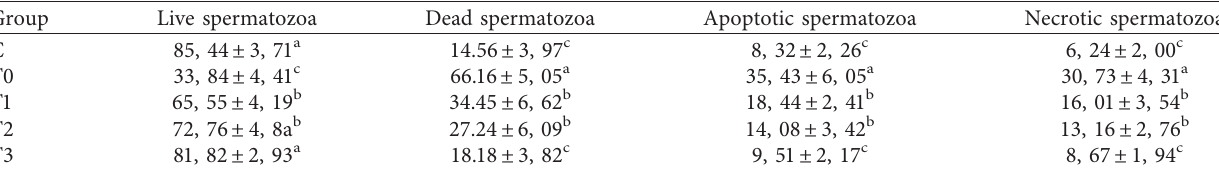
Table 2: The percentage of live, dead, apoptotic, and necrotic spermatozoa (%) of rats exposed to TCDD and treated with α -tocopherol.